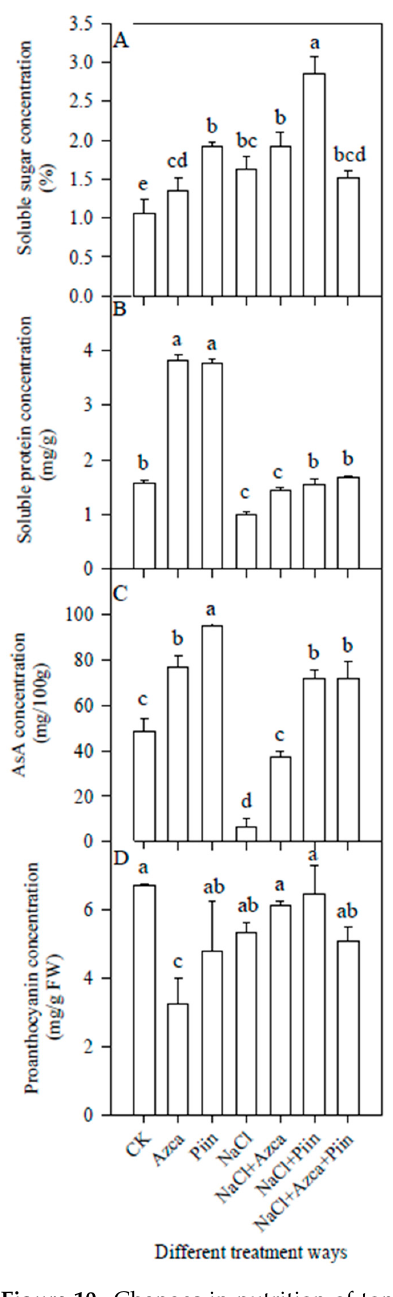
Figure 10. Changes in nutrition of tomato fruits under different treatments. ( A ): soluble sugars; ( B ): soluble proteins; ( C ): ascorbate; and ( D ): total proanthocyanins. Results were shown as mean ± SE ( n = 3). The means with the same lowercases indicate that the differences were not significant ( p > 0.05).